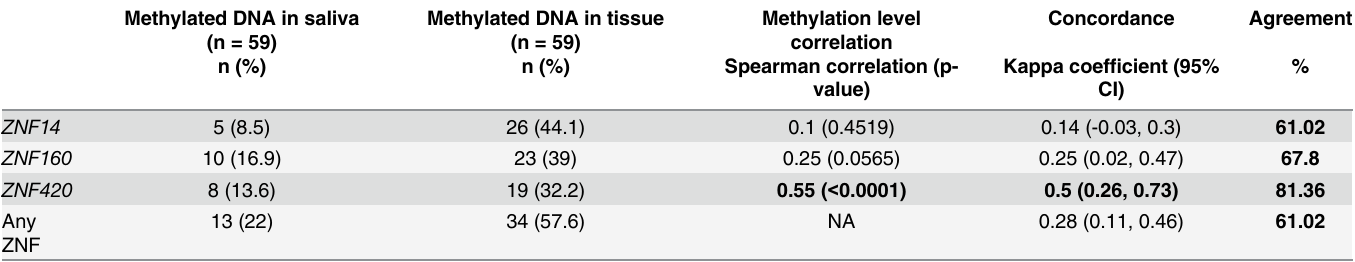
Table 2. Correlation, concordance and agreement of ZNF DNA methylation signal in salivary rinses and in primary tissues from the validation cohort. Methylated DNA in saliva (n =